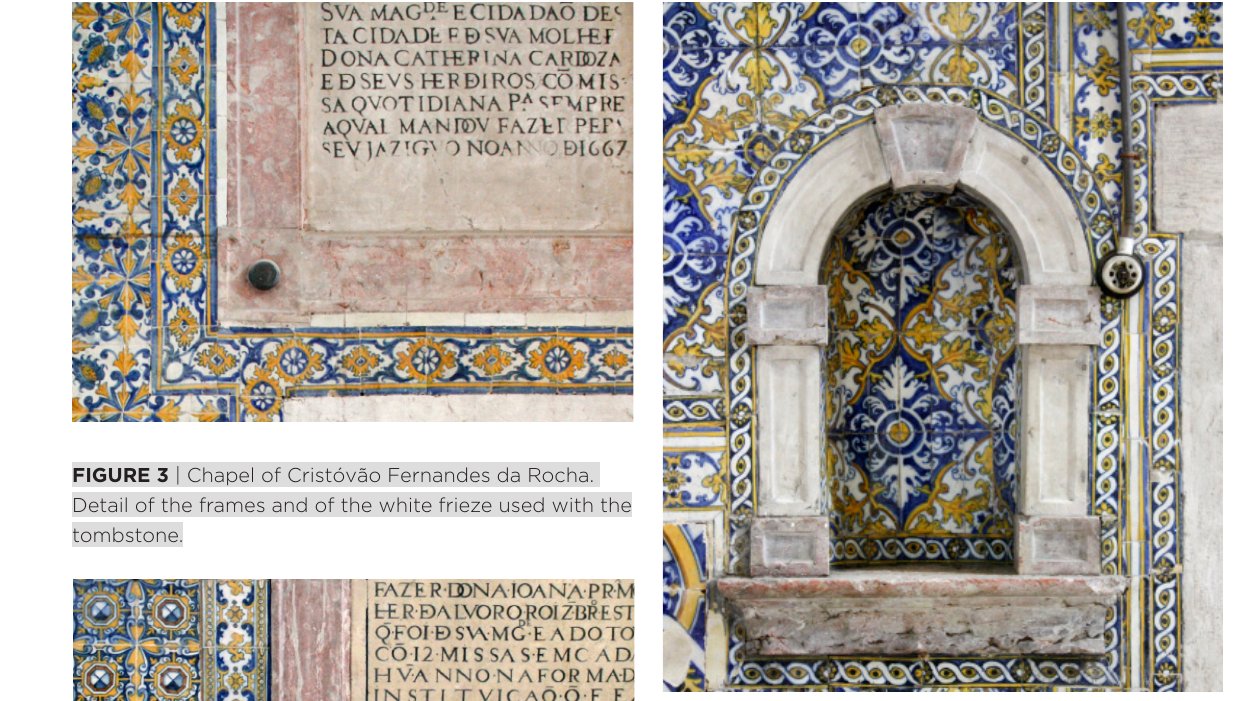
FIGURE 5 | Chapel of Gaspar Vieira de Araújo. Detail of the niche with a frieze and, in the interior, with the same pattern of the